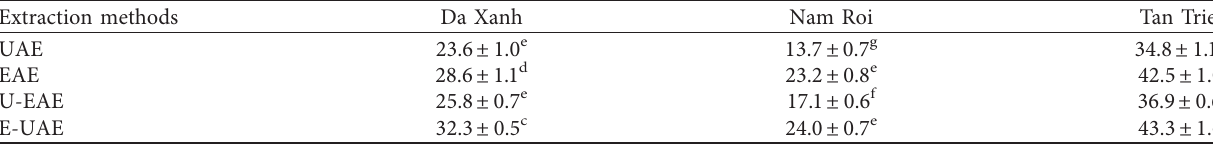
Table 2: DPPH scavenging capacity (%) of extracts from pomelo peels 1 .